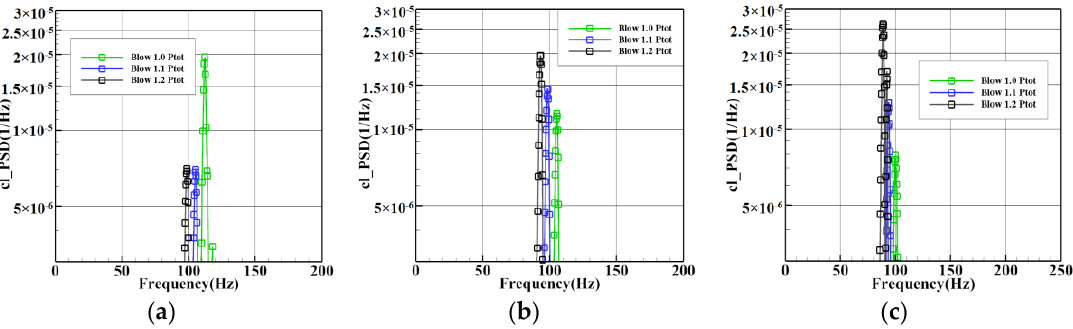
Figure 14. PSDs of unsteady lift coefficient histories under different blowing total pressures at different incidence angles: ( a ) 5.0°, ( b ) 5.5°, and ( c ) 6.0°.